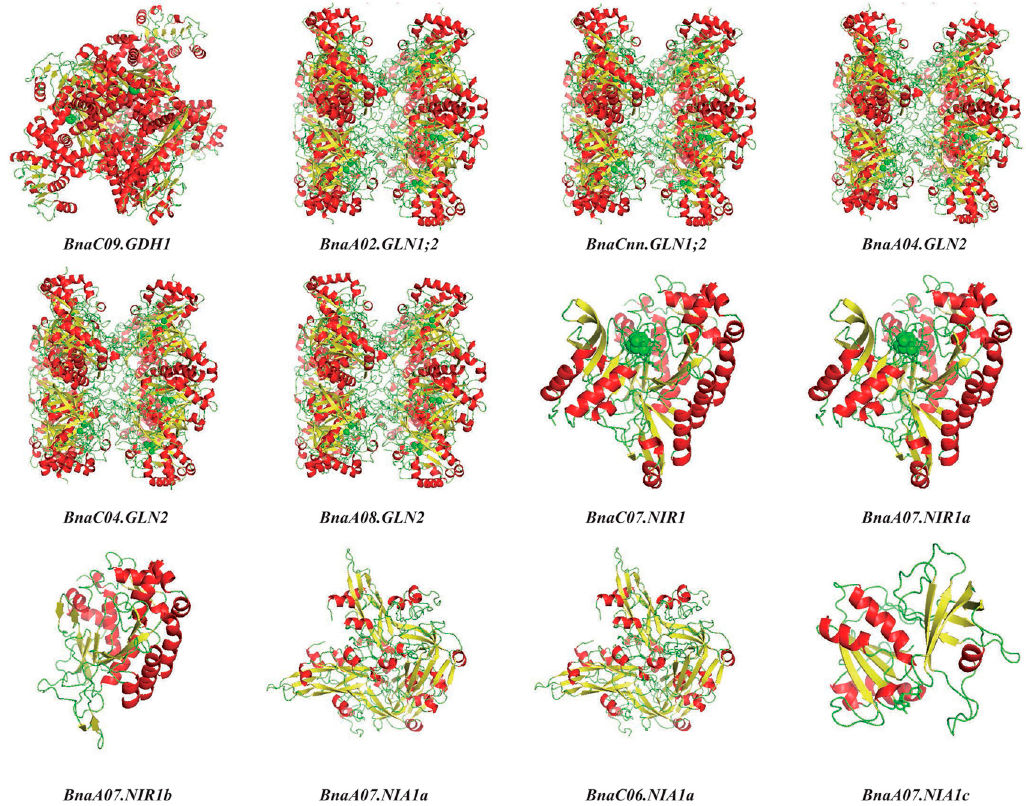
Figure 10. Predicted 3D structure of 12 core proteins associated with N assimilation using the SWISS-MODEL online software. The structure image is generated using the pymol software. The red, yellow and green color indicates alpha helix, beta turn and random coil, respectively.